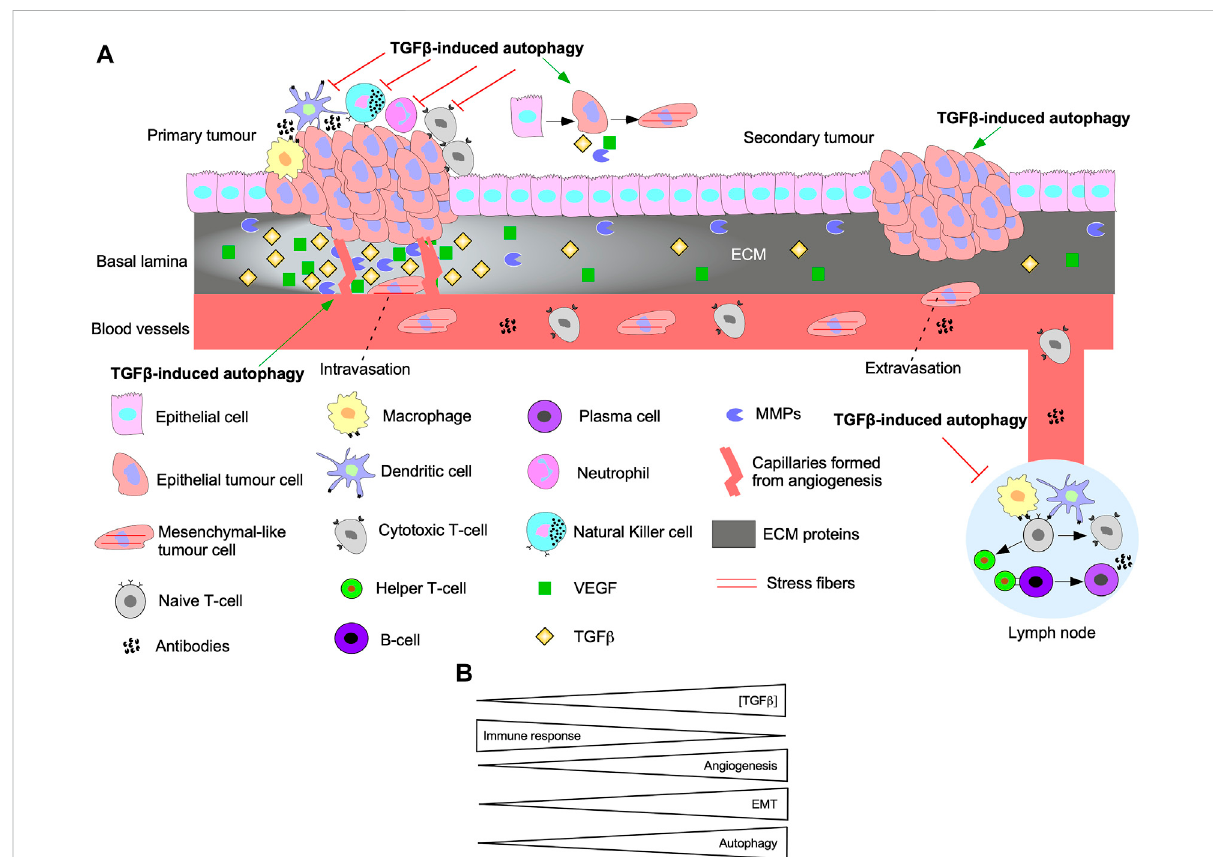
FIGURE 11 The interplay between autophagy and TGF β signalling in tumourigenesis. (A) A schematic summarizing the effect of TGF β -induced autophagy onEMT,immunesurveillance,angiogenesis,andmetastasis.EpithelialcellsacquiremutationstotheTGF β pathwayuntiltheybecomecancerousand proliferate rapidly to form the primary tumour. TGF β -induced autophagy protects tumour cells from the innate immune system (macrophages, dendritic cells, neutrophils, Natural Killer cells)and cells of theadaptive immunesystem (Naive T-cell,CytotoxicT-cells, Helper T-cells, B-cells, and plasma cells). Furthermore, TGF β and autophagy can prevent activation of immune cells that reside in lymph nodes. TGF β -induced autophagy promotes the release of vascular endothelial growth factor (VEGF) that stimulate angiogenesis. Over time, cells acquire a mesenchymal-like phenotype and release matrix metalloproteinases (MMPs) to breakdown the basal lamina and intravasate into the bloodstream. TGF β -induced autophagy promotes intravasation because it protects cells that detach from the basal lamina against anoikis-dependent cell death. The mesenchymal-like tumour cells extravasate from the blood vessel at a distant site from the primary tumour. Autophagy is critical for promoting phenotypes to help tumour cells adapt to new environments and establish secondary tumour sites. (B) As the concentration of transforming growth factor- β (TGF β ) increases, the immune response is inhibited, whereas angiogenesis, epithelial-mesenchymal transition (EMT), and autophagy are